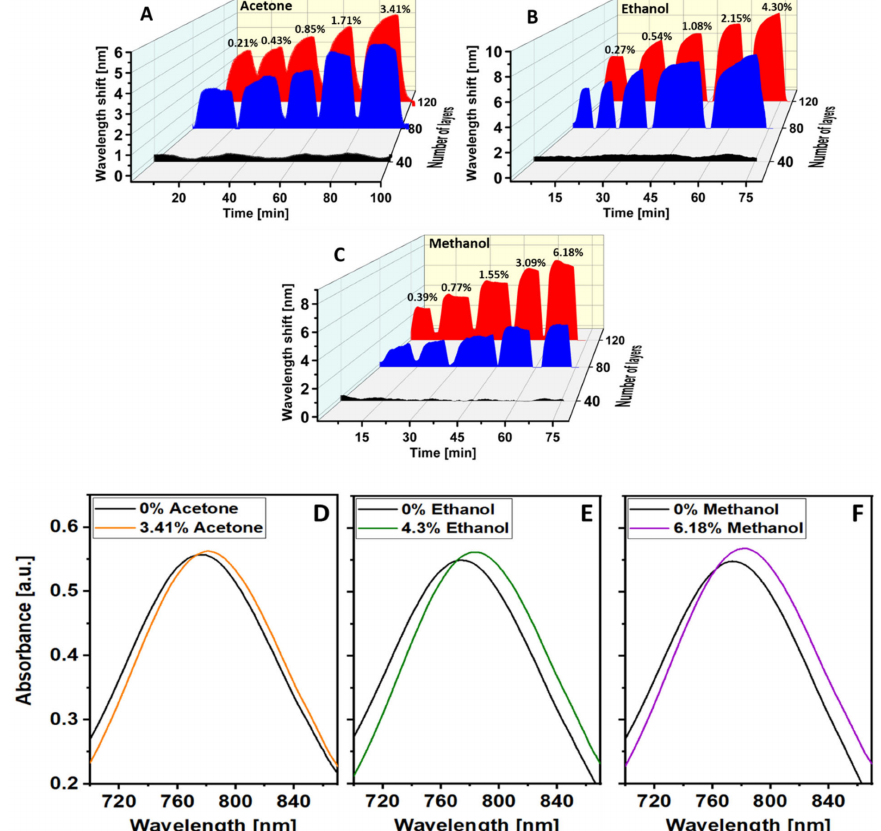
Figure 7. The dynamic response of peak wavelength position of the optical fibre sensor coated with 40 (black trace), 80 (blue trace) and 120 (red trace) coating cycles of HKUST-1 to different concentrations of ( A ) acetone, ( B) ethanol and ( C ) methanol. The spectral changes of the 120-cycle-coated sensor to different concentrations of ( D ) acetone, ( E ) ethanol and ( F )